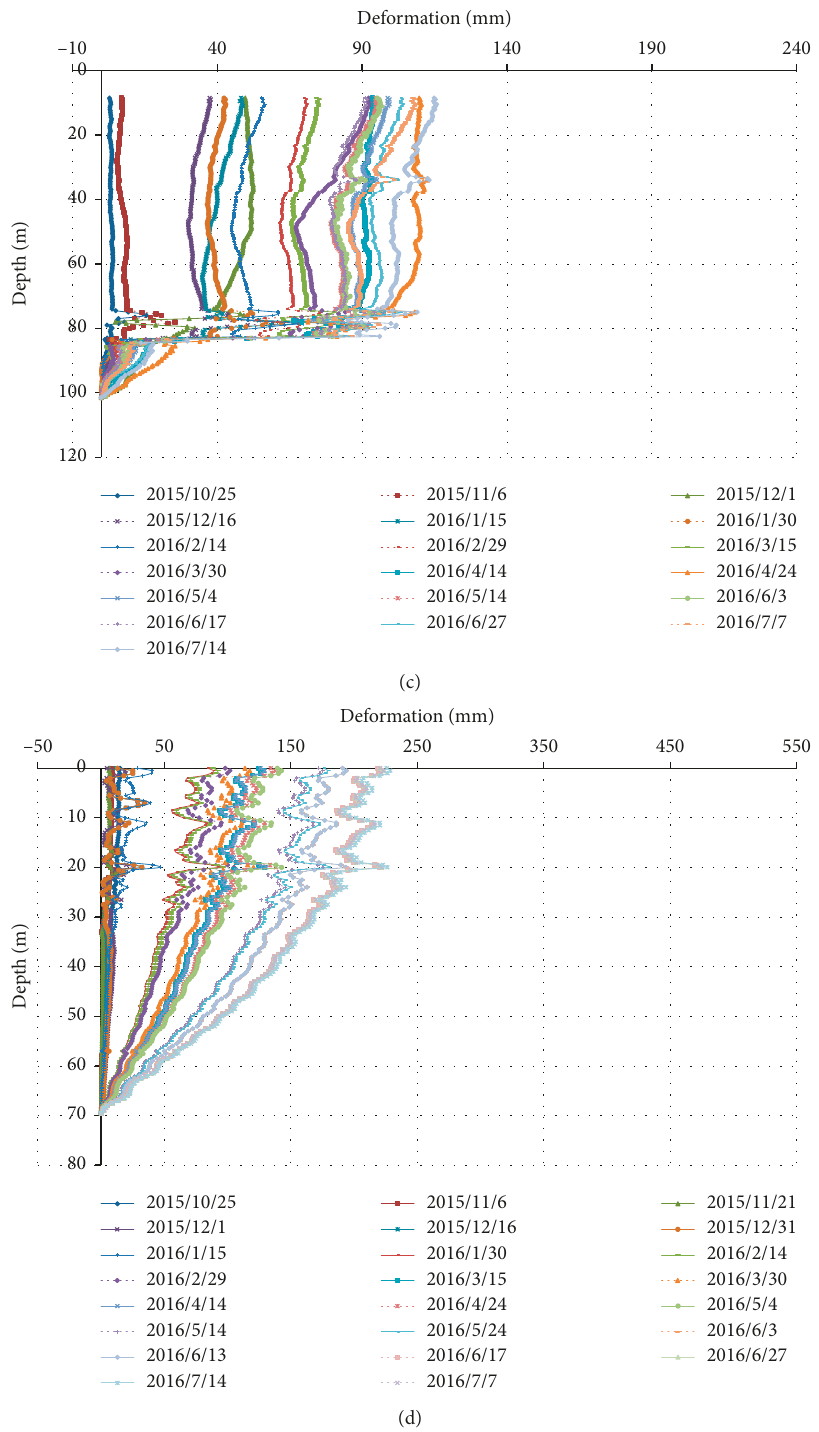
Figure 5: Cumulative displacement curve at different elevations for the inclination survey of DH-2-2 Section. (a) Elevation 1,710m. (b) Elevation 1,650m. (c) Elevation 1,550m. (d) Elevation